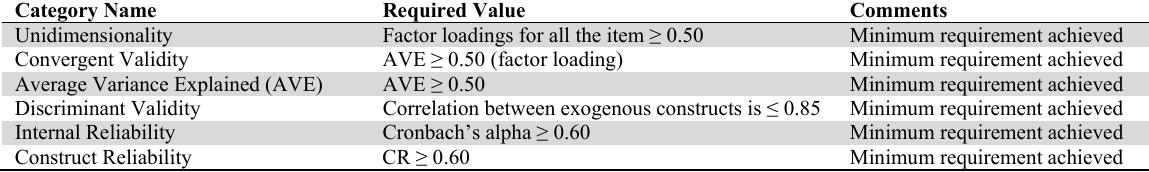
Fitness Assessment of the Results Attained for Measurement Model